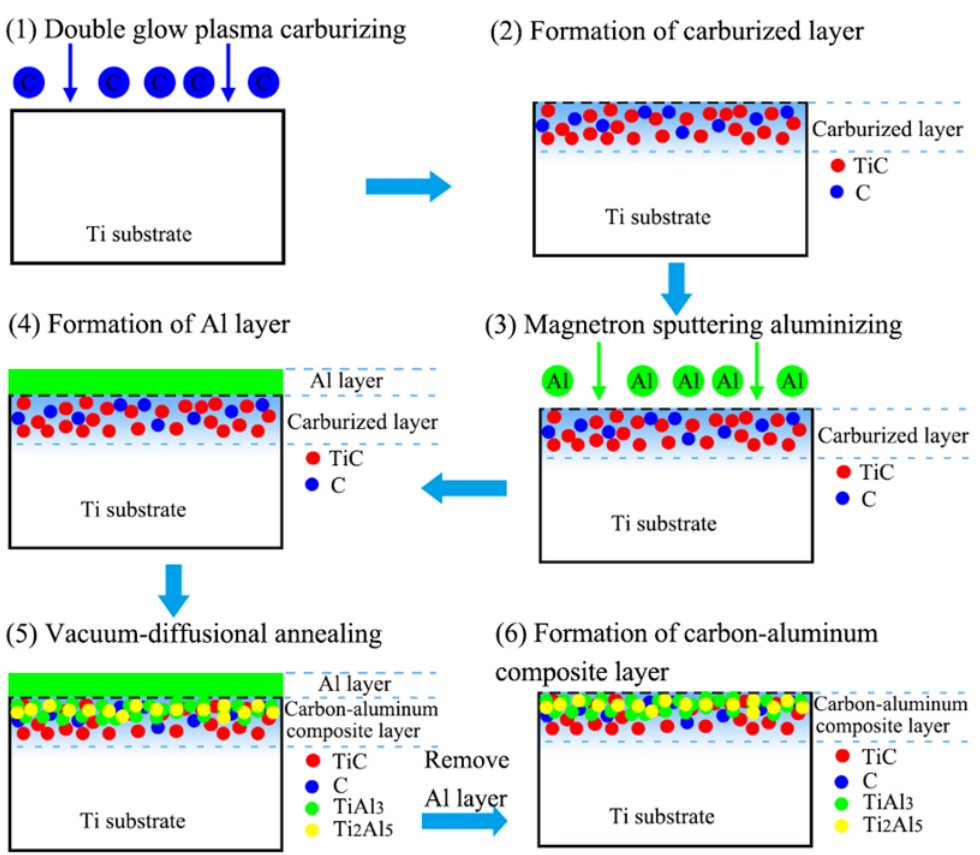
Figure 13. Schematic diagram of the formation process of the carbon–aluminum composite layer.